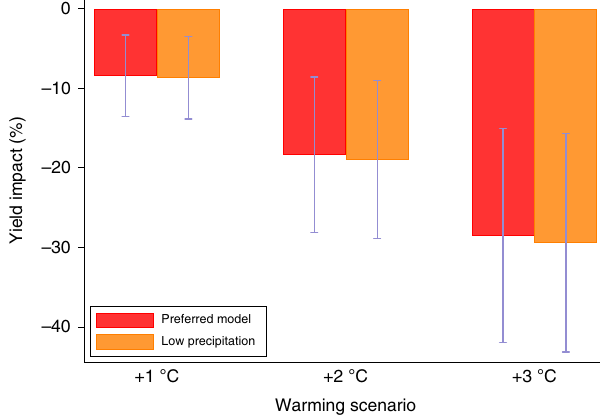
Fig. 2 Marginal effects of temperature bins on wheat yields. The solid line represents the change in mean log yield if the crop is exposed for one day (24 h) to each 5 °C temperature bin. Dashed lines represent the 95% con fi dence intervals using standard errors clustered by province-year. These results follow similar patterns to those found in Schlenker and Roberts (2009) 43 wherein yields are relatively stable across temperature bins prior to a marginal yield improvement at seemingly optimal temperatures. When critical thresholds are reached, 30 °C in this case, sharp yield reductions